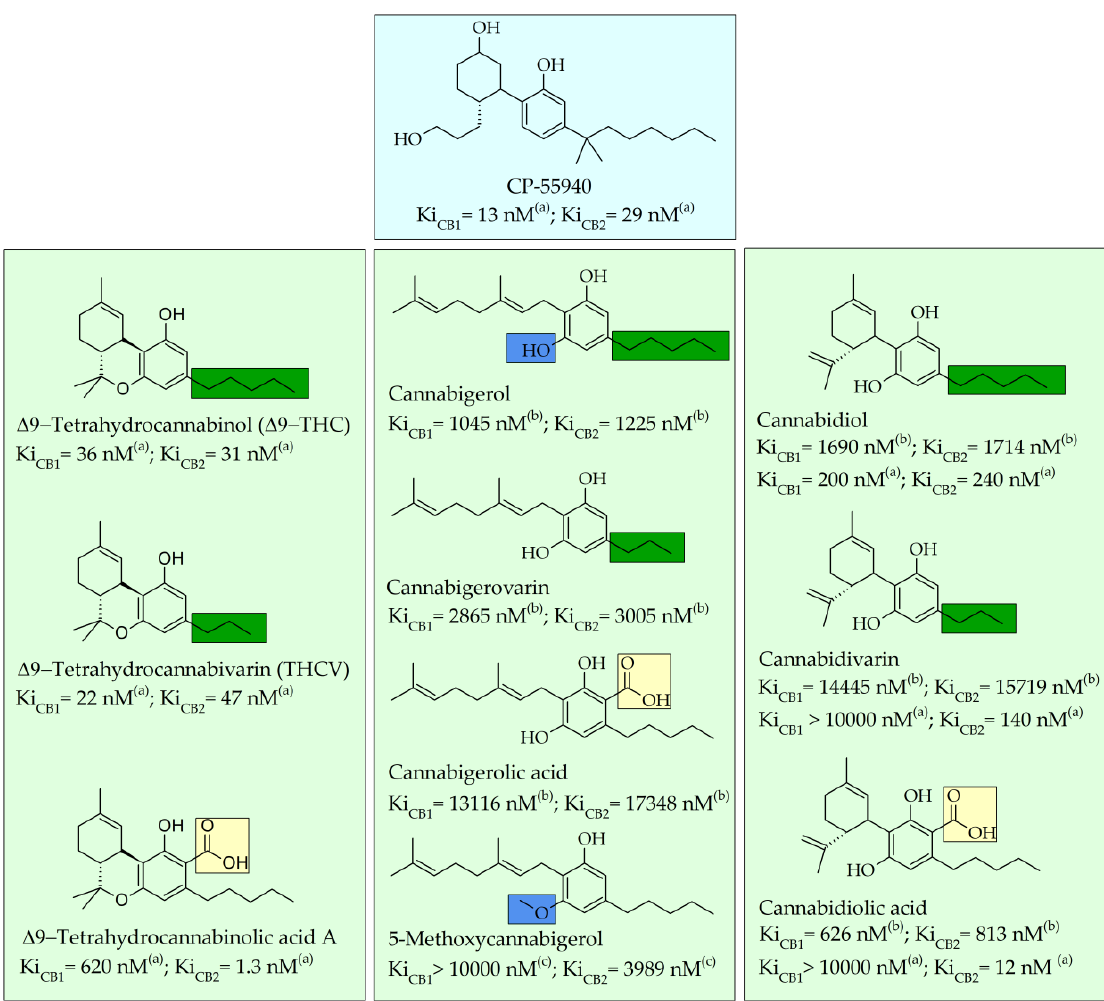
Figure 1. Chemical structures and binding affinities of ten major phytocannabinoids able to cause, in vitro, the displacement of synthetic [ 3 H]CP55940 bound to human cannabinoid receptors 1 or 2 both embedded in cellular membranes. The binding affinities are reported according to the published data available in the following scientific articles: a [65]; b [70]; c [68].The chemical structures were prepared with ACD/ChemSketch, and the three classes of phytocannabinoids are included in separate inserts. The substituents of the resorcinyl moiety whose replacements cause a change in affinity constants (Ki) are highlighted.